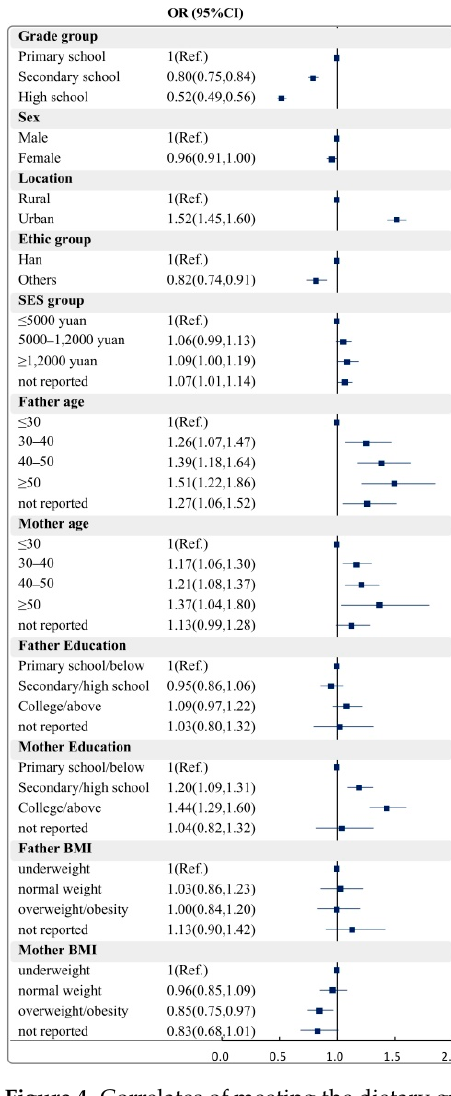
Figure 4. Correlates of meeting the dietary guidelines among children and adolescents. BMI: body mass index; SES: social economic status; OR: odds ratio; 95%CI: 95%confidence interval. mass index; SES: social economic status; OR: odds ratio; 95%CI: 95%confidence